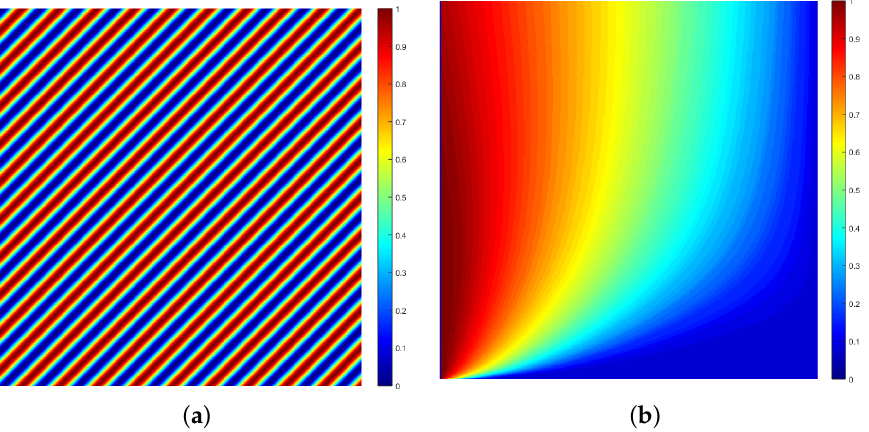
Figure 3. Comparison of the space-time maps for the propagation of photons through an open shutter into a homogenous space ( a ) and an inhomogeneous space consisting of a complex of random scatterers ( b ). In both cases, the horizontal axis and the vertical axis, are of space x and time t , respectively, where ( 0,0 ) is the lower left-hand corner of the map. ( a ) space-time map of the real component of the function u ( x , t ) , x ∈ [ 0,1 ] , t ∈ [ 0,1 ] given by Equation (47) for k = ω = 20 π ; ( b ) space-time map of the photon density due to the diffusion of light given by u ( x , t ) in Equation (57) for x ∈ [ 0,1 ] , t ∈ [ 0 + ,1 ] with Diffusivity D =